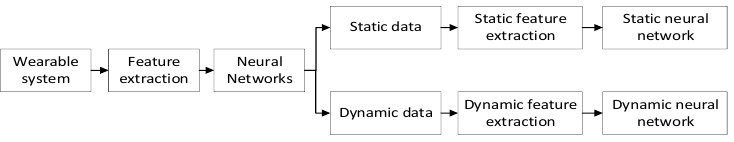
Figure 6. Motion pattern recognition model test flow.